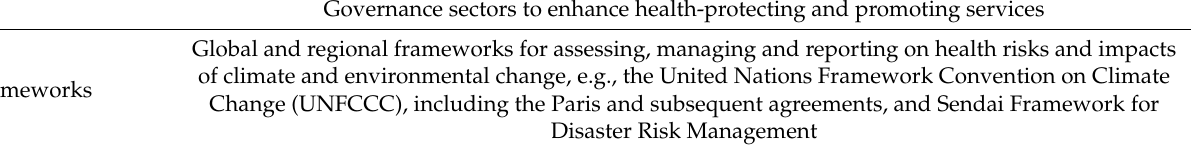
Table 7. Sub-competencies for Domain 6: Partnerships and collective strategies-international and regional, agreements and frameworks.